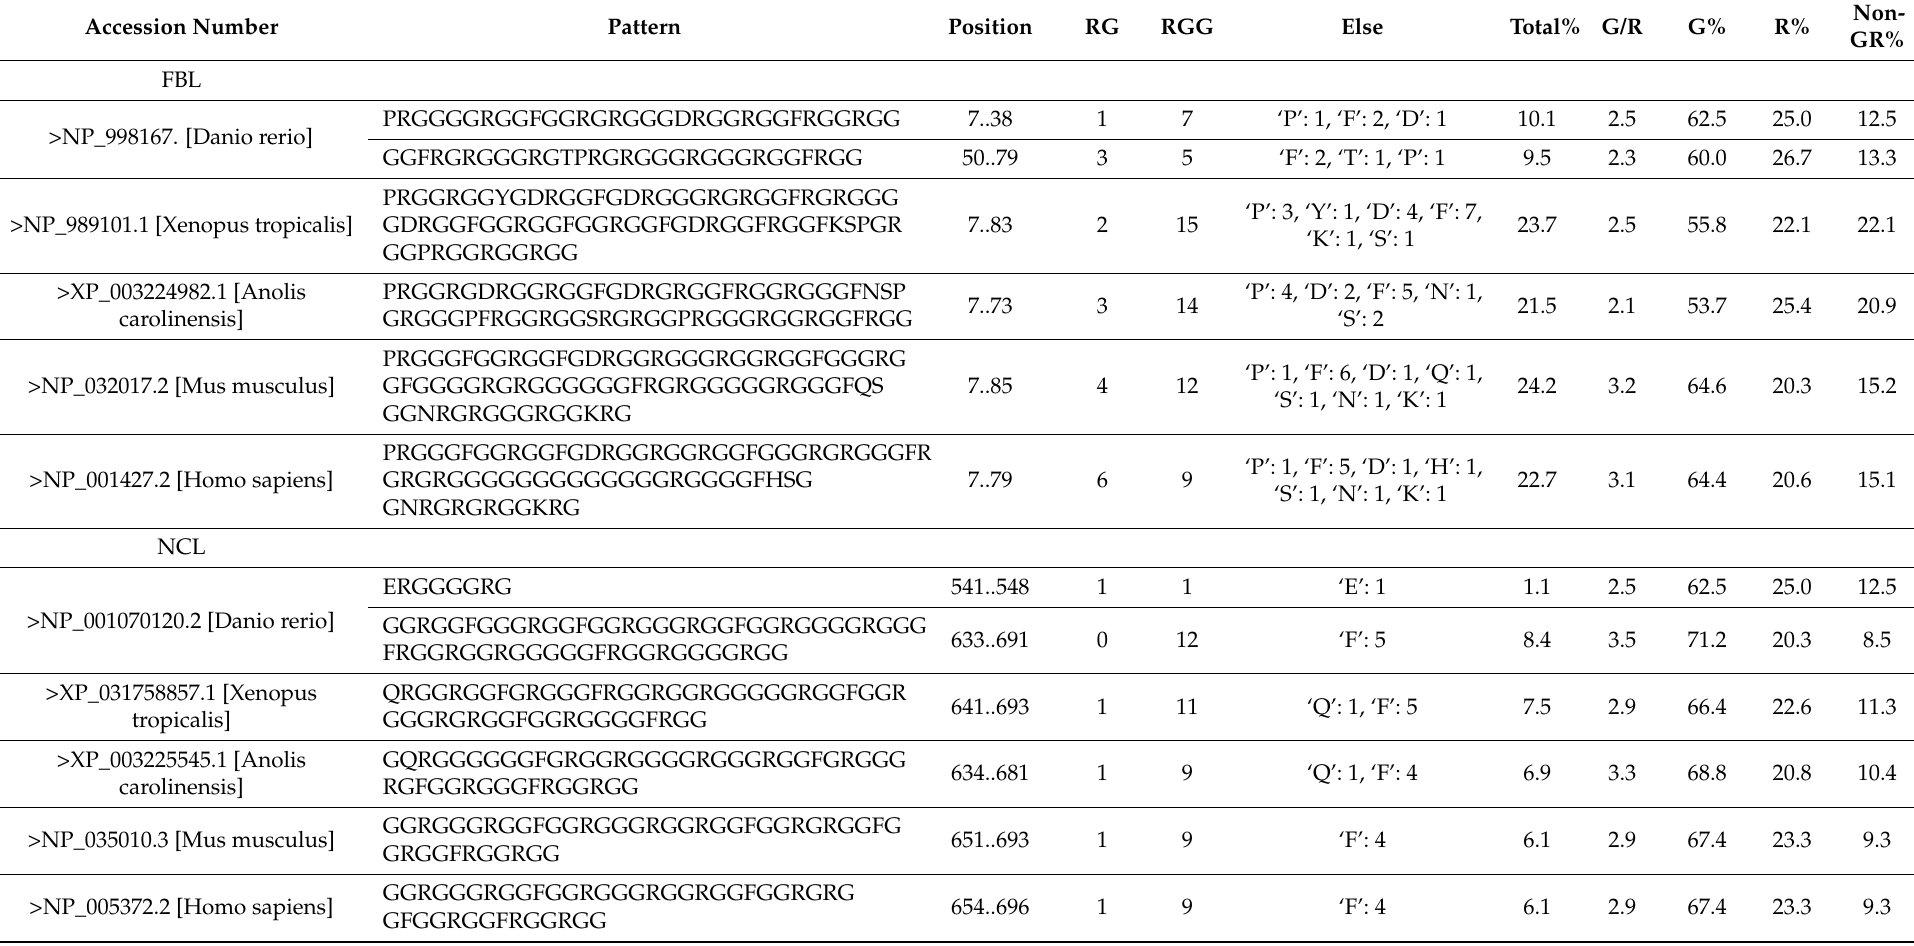
Table 2. Analyses of the GAR motifs in FBL, NCL, and GAR1 in five model vertebrate species by